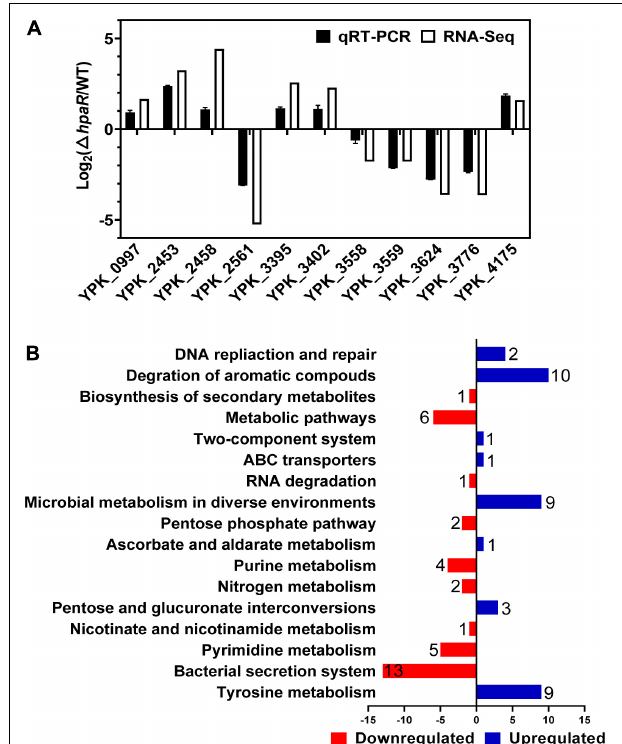
FIGURE 2 | Transcriptomics analysis of HpaR regulated genes in Y. pseudotuberculosis . (A) Validation of RNA-Seq data using qRT-PCR. Eleven representative genes were evaluated for validation of the RNA-seq data using qRT-PCR. (B) KEGG pathway analysis of differentially expressed genes ( hpaR mutant VS wild-type). The red and blue bars represent up- and down-regulated genes, respectively, and the numeric labels represent the number of genes with corresponding